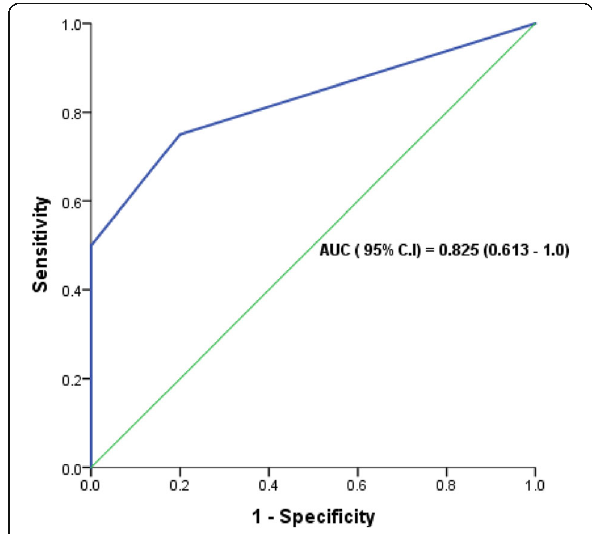
Fig. 5 ROC curve for pleural thickness values in the benign and malignant pleural effusion. Area under the curve =